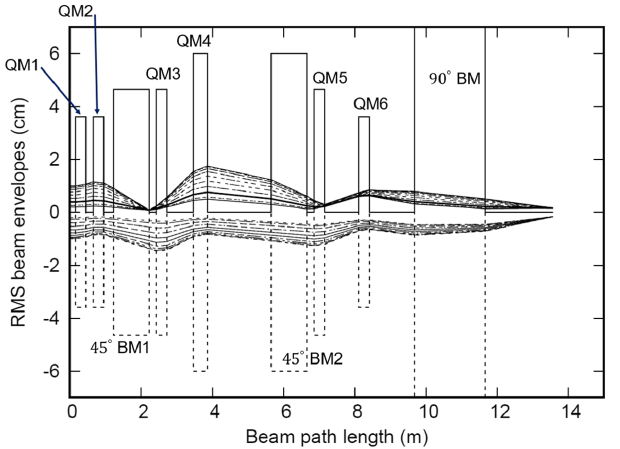
FIG. 3. Root-mean-square beam envelopes with respect to the rotation angle at the gantry entrance. Upper curves show horizontal envelopes; lower curves show vertical envelopes, as a function of rotation angles up to (cid:2) 180